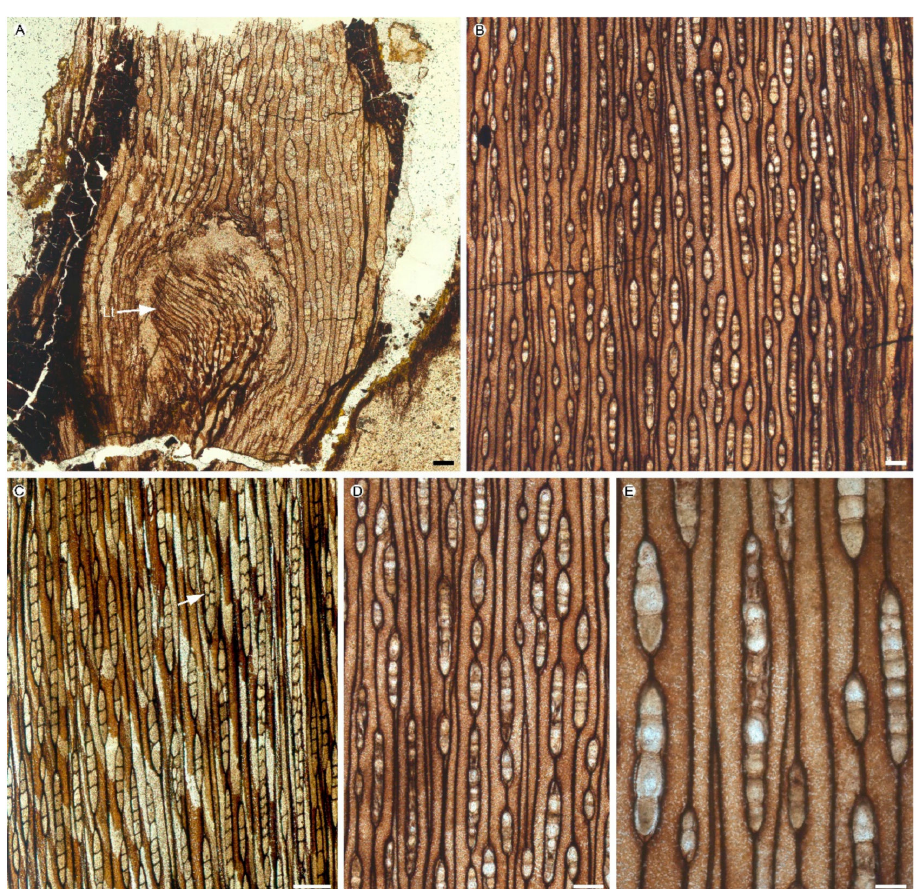
Figure 7. The xylem structure of Tingia unita from the Taiyuan Formation of Wuda Coalfield, Inner Mongolia. ( A – E ) Tangential section of the stem. Showing the uniseriate to partly biseriate rays. Few ray cells are relatively small than others in the same ray (arrow), and a putative leaf trace (Lt). Scale bars: ( A ) = 100 µ m; ( B ) = 100 µ m; ( C ) = 100 µ m; ( D ) = 100 µ m; ( E ) = 50 µ m. Collection numbers: ( A , B , D , E ) PB201150; ( C ), PB201152. Slide numbers: ( A ) PB201150-14; ( B , D , E ) PB201150-16;